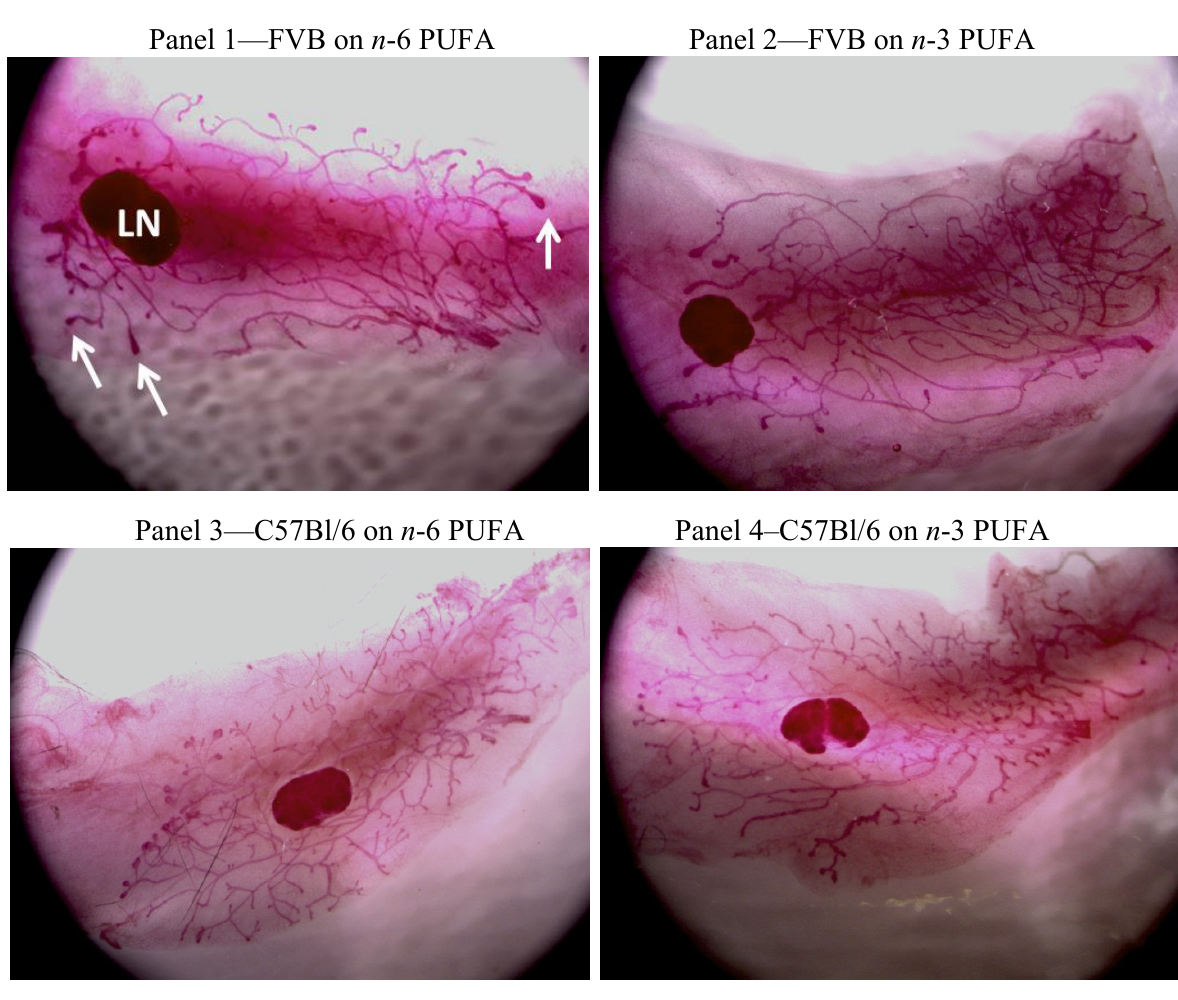
Figure 2. Representative stereoscopic wholemount images (20×) of the left fourth mammary gland (MG) at 6 weeks of age, from FVB and C57Bl/6 mice fed n -6 or n -3 PUFA. FVB on n -6 PUFA (Panel 1), FVB on n -3 PUFA (Panel 2), C57Bl/6 on n -6 PUFA (Panel 3) and C57Bl/6 on n -3 PUFA (Panel 4). Arrows show representative terminal end buds (TEB) enumerated. Lymph node